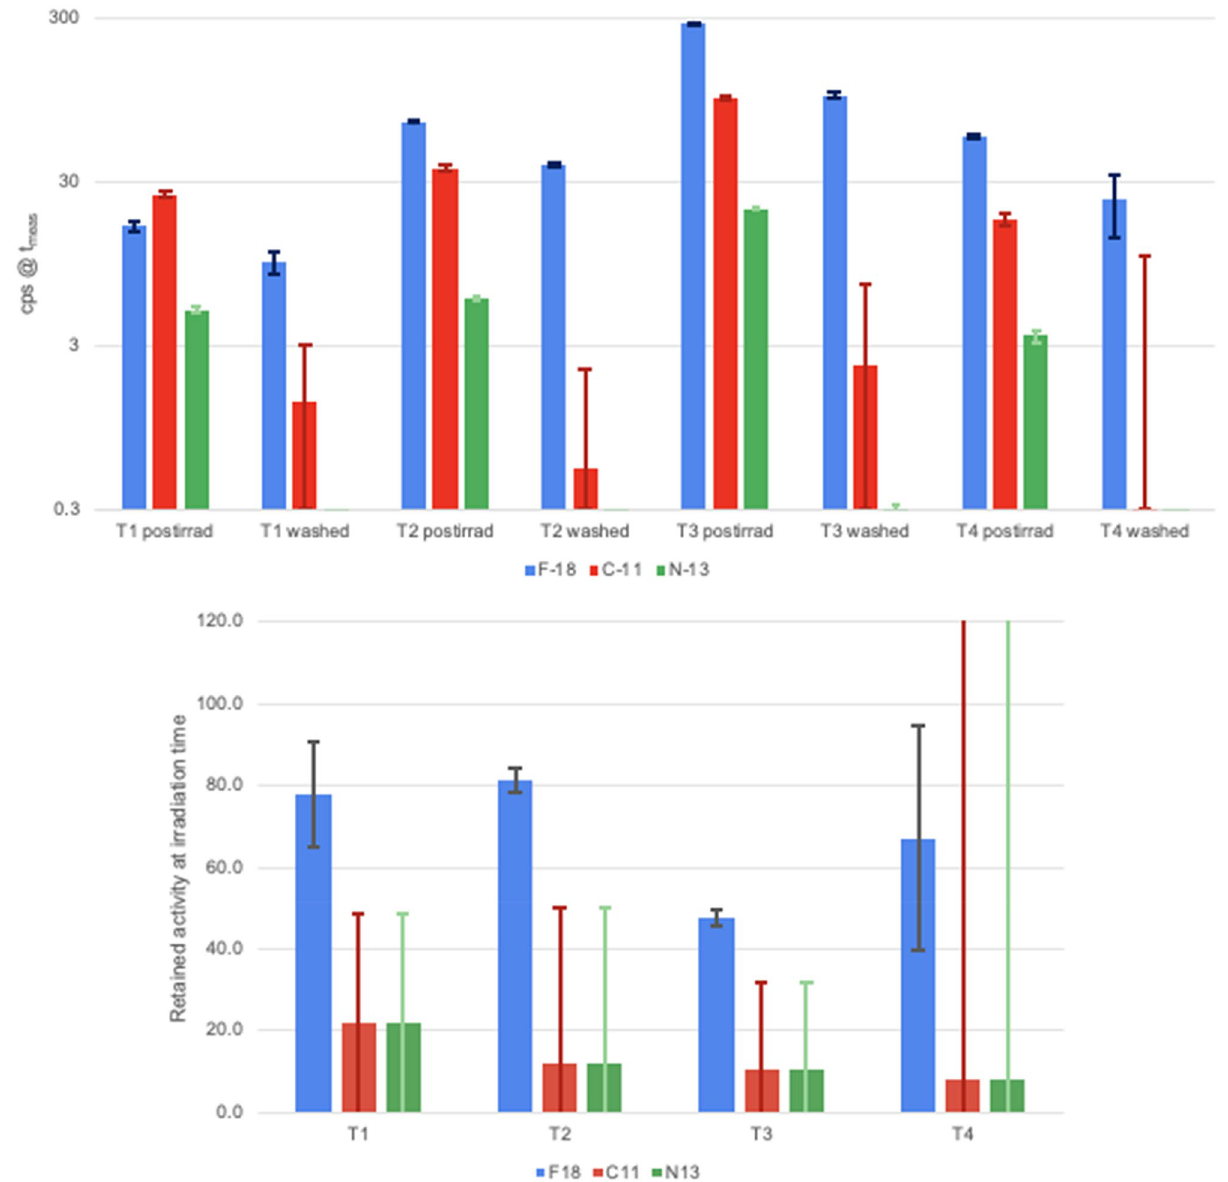
Figure 6. (top) Measured activity in counts per second (cps) from tumors T1–T4 corresponding to 11 C (red), 13 N (green), and 18 F (blue) at the beginning of the measurements (t meas ), performed at post-irradiation time and on washed tumors. (bottom) Percentage of retained activity on the irradiated tumors (T1–T4) obtained by comparison of the decay-corrected specific activity at the irradiation time before and after washing the tumors. Error bars represent the 1-sigma confidence